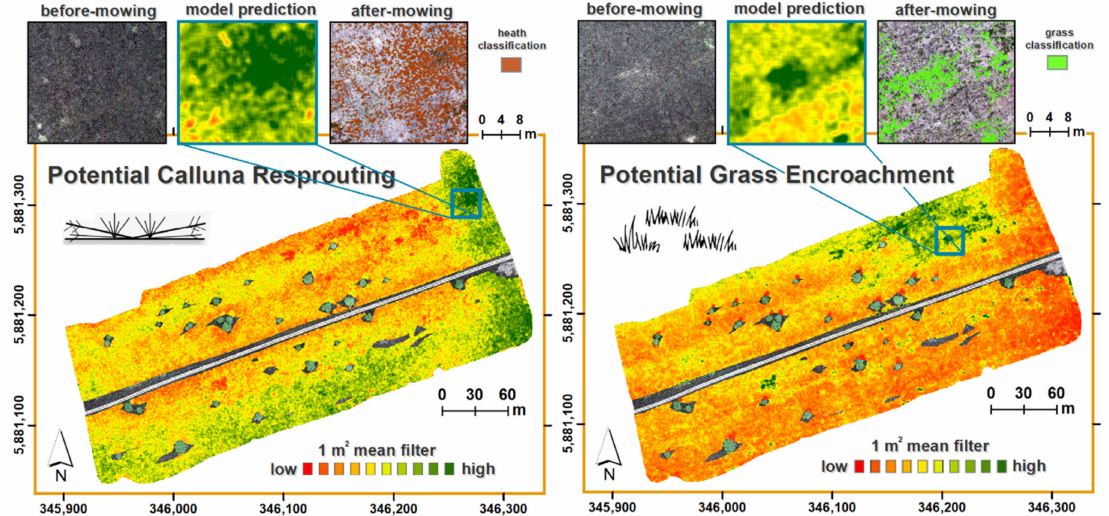
Figure 5. Drone based spatially explicit predictions of Calluna resprouting and grass encroachment after mowing using before-mowing plant optical traits and structural